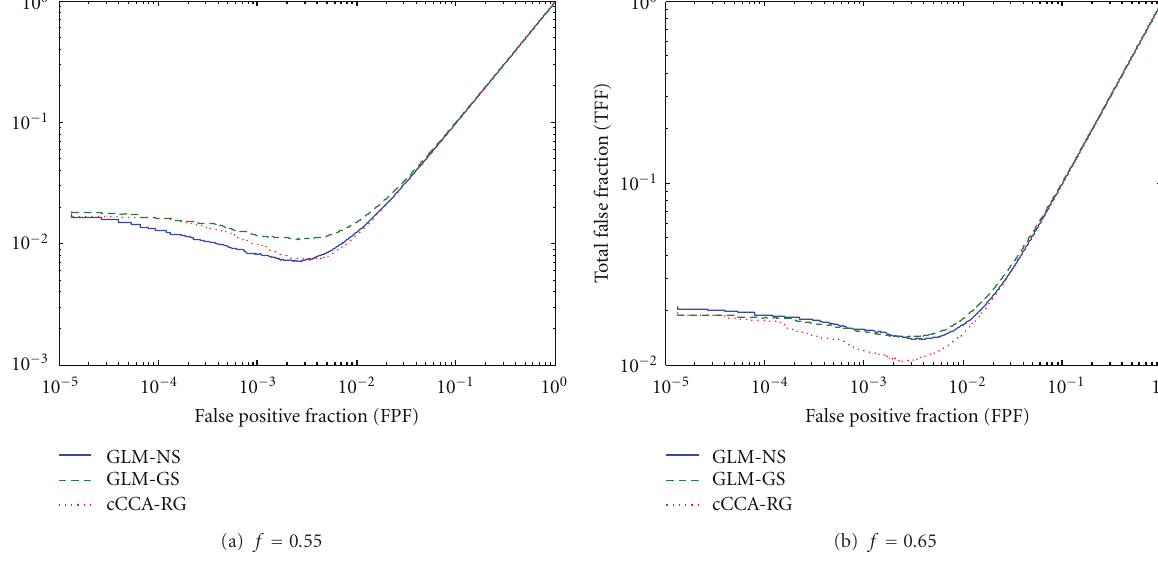
The slices shown in the upper row contain an anterior por- tion of the hippocampal complex. Symmetrical activations in hippocampus and parahippocampal gyrus are detected by GLM-NS and cCCA-RG. The missing activation at the left hippocampus (see white arrows) of GLM-GS demonstrates the undesirable e ff ects of a fixed isotropic Gaussian spatial smoothing on localized weak activation patterns. A more